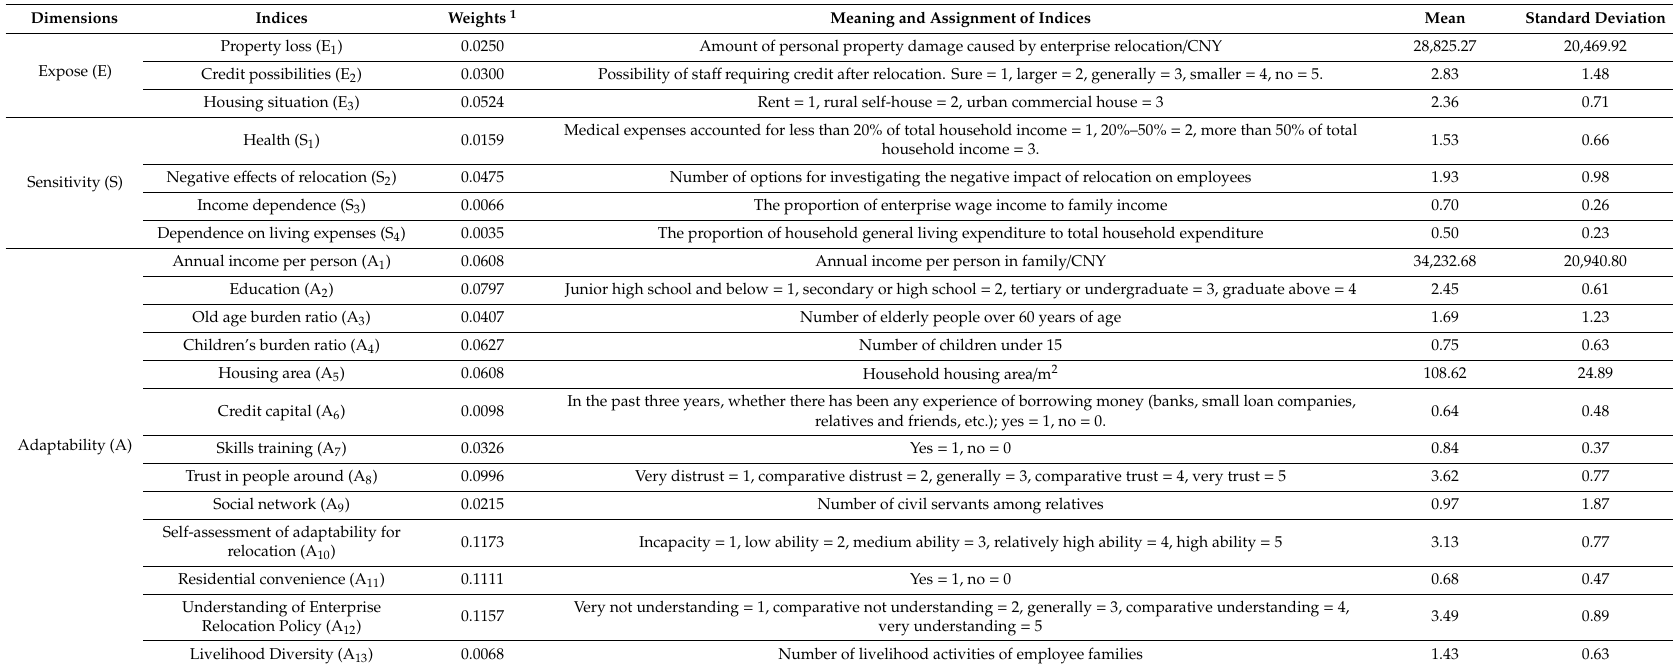
Table 1. Evaluation index system of livelihood